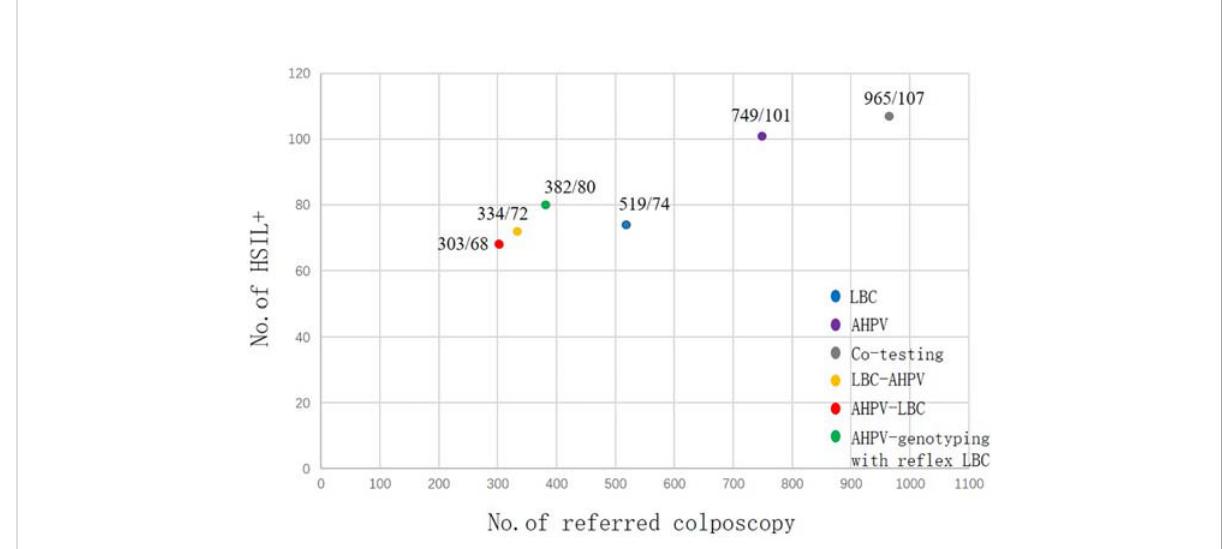
FIGURE 4 Screening ef fi ciency of the different primary screening and three triage strategies for HSIL+. HSIL, high-grade squamous intraepithelial